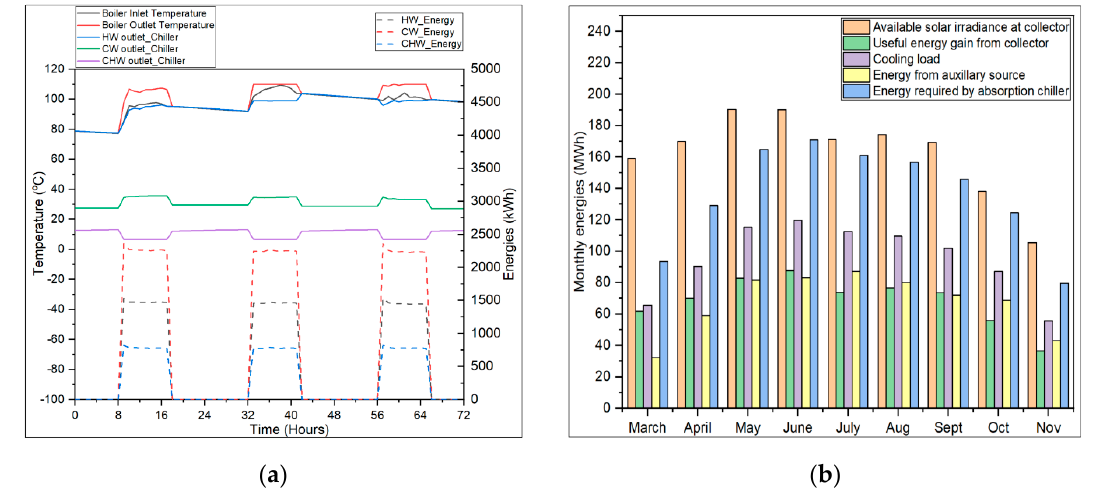
Figure 10. ( a ) Chiller outlet temperature and energies of hot water, cooling water and chilled water loop for three days from 03.06. to 05.06. ( b ) evacuated tube collector (ETC) + absorption chiller results at collector area (A c ) = 1000 m 2 .